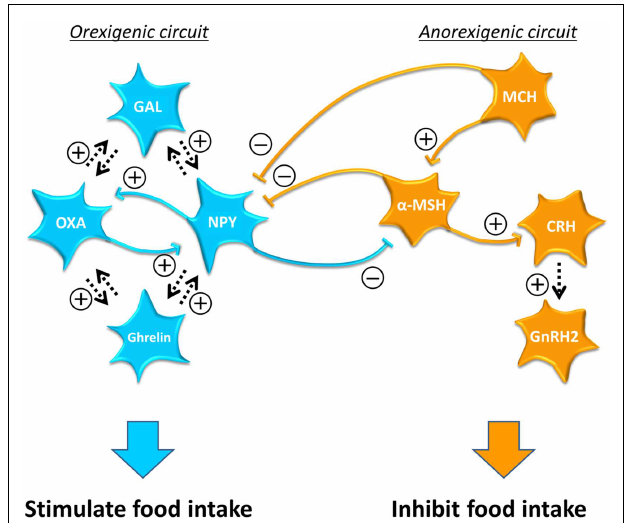
FIGURE 2 | Interaction between the orexigenic circuit and anorexigenic circuit and among neurons in each circuit in the goldfish . Hormones in the orexigenic circuit are shown in blue and those in the anorexigenic circuit are shown in orange.The orexigenic and anorexigenic circuits are connected each other via inhibitory neuronal fiber projections to form an on-off switch. Reciprocal interaction is observed especially between neurons in the orexigenic circuit. Arrows with dotted lines indicate the interactions that have not been confirmed whether direct or indirect.The complex interaction among metabolic neuropeptides suggests that a change in one metabolic signal can affect the reproductive system through the action via other metabolic neuropeptides. Note that in the goldfish ghrelin secreted in the brain also function as an orexigenic signal. α -MSH, alpha-melanocyte stimulating hormone; CRH, corticotropin-releasing hormone; GAL, galanin; GnRH, gonadotropin-releasing hormone;